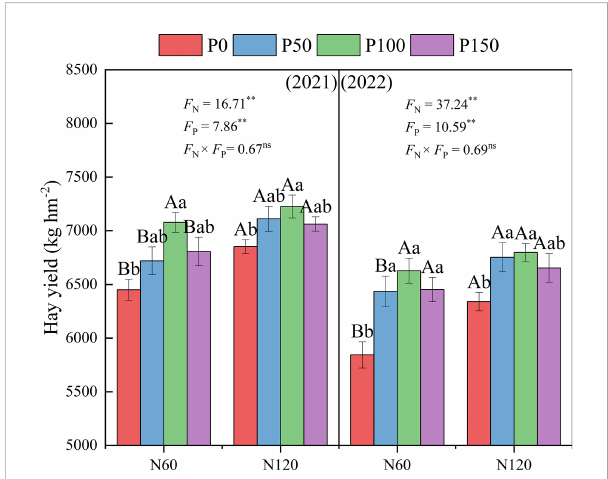
FIGURE 4 Effect of nitrogen and phosphorus combined fertilization on the hay yield ( fi rst clipping) of alfalfa in 2021 to 2022. Different small letters indicate signi fi cant differences between different P fertilizer treatments under the same N application condition ( p < 0.05). Different capital letters indicate signi fi cant differences between different N fertilizer levels under the same P application condition ( p < 0.05). F N , F P and F N × F P represent the F value under the N application levels, P application levels and the interaction of N and P application levels, respectively. ns indicates no signi fi cant difference ( p > 0.05), * indicatessigni fi cant difference ( p < 0.05)and **indicates extremelysigni fi cant difference( p <